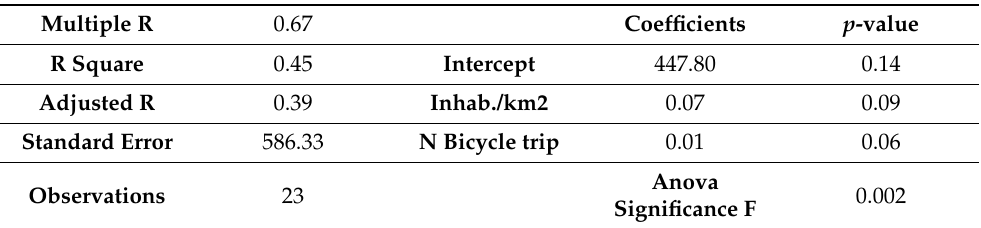
Observations 23